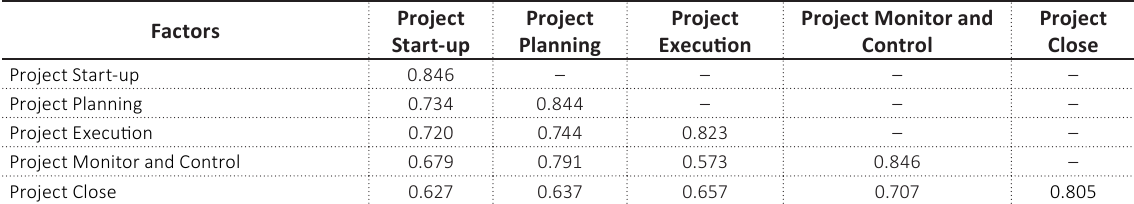
Table 5. Results of discriminant validity by the Fornell-Larcker criterion Factors